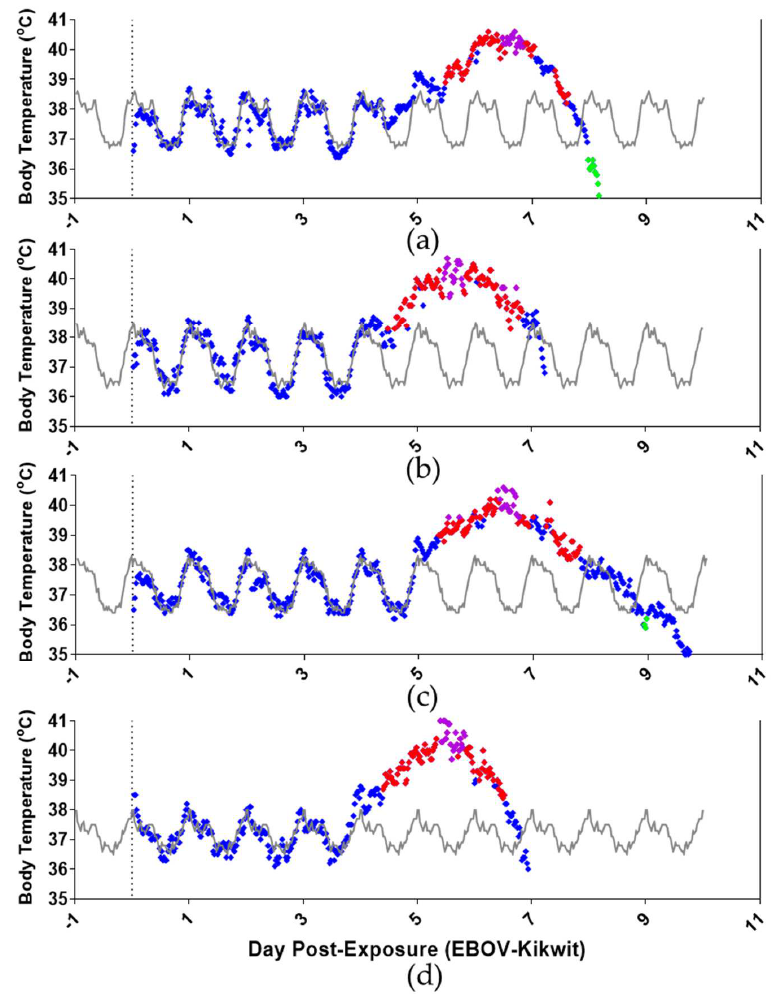
Figure 2. Telemetric temperature detection of aerosol EBOV-challenged rhesus macaques: ( a ) NHP1, ( b ) NHP2, ( c ) NHP3, and ( d ) NHP4. Vertical grey dotted line marks DPE 0—BL (baseline), ♦ marks fever (>1.5 °C over baseline) for longer than 2 h, ♦ marks LS (values significantly lower: <3.0 SD from corresponding baseline) for longer than 2 h, ♦ marks temperature (°C) for longer than 2 h, and ♦ marks hyperpyrexia (>3.0 °C over baseline) for longer than 2 h.